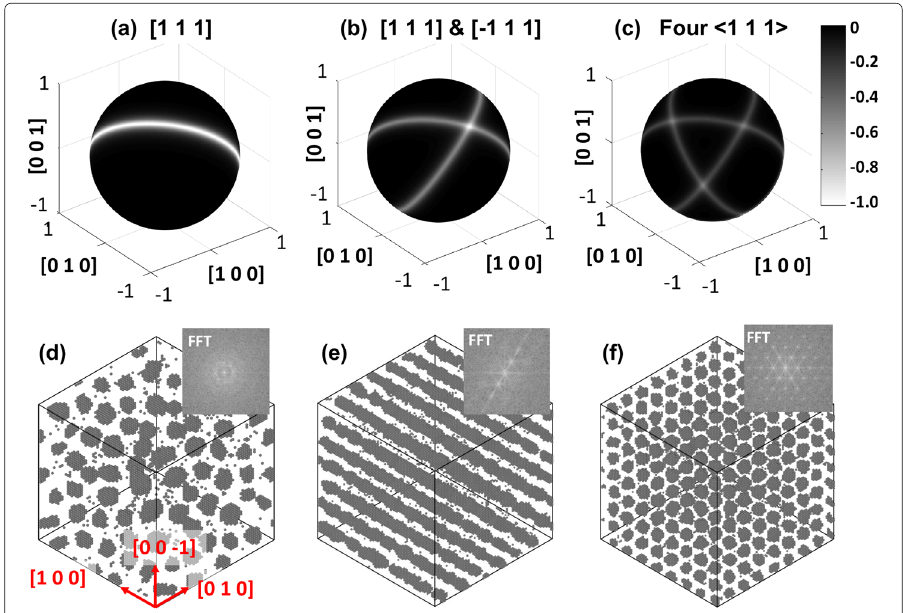
indeed observed in AKMC shown in Fig. 3d. The appearance of a ring in the fast-Fourier- transformation (FFT) image indicates the existence of a characteristic length but not a symmetry. In both case I and II, voids align along the 1D SIA diffusion directions when instability occurs, consistent with the shadowing effect hypothesis (Forreman 1972; Woo and Frank 1985).